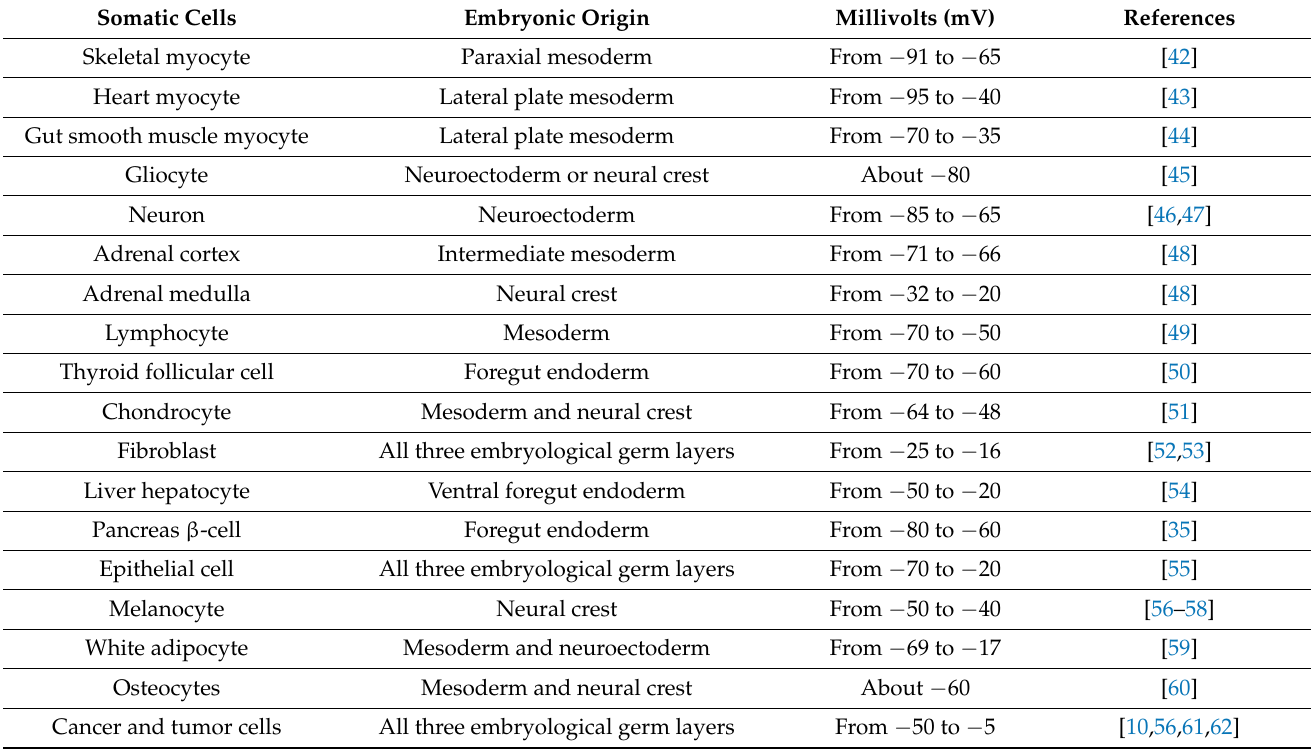
Table 1. Reported cellular membrane potential of common vertebrate cell